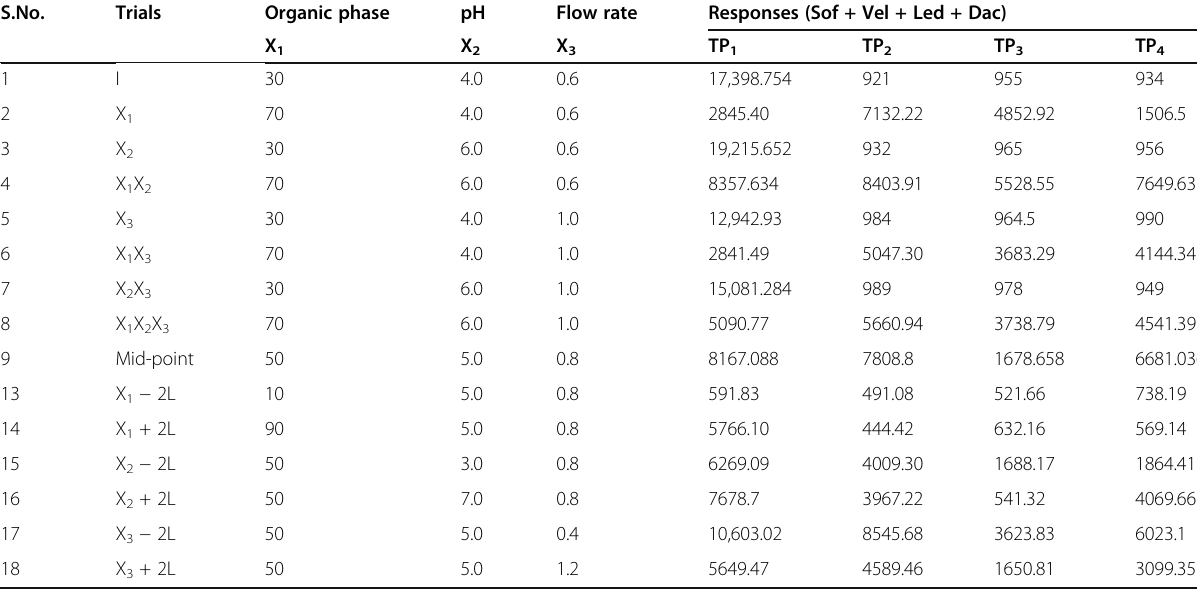
Table 4 Central composite plan of anti-viral drugs S.No.